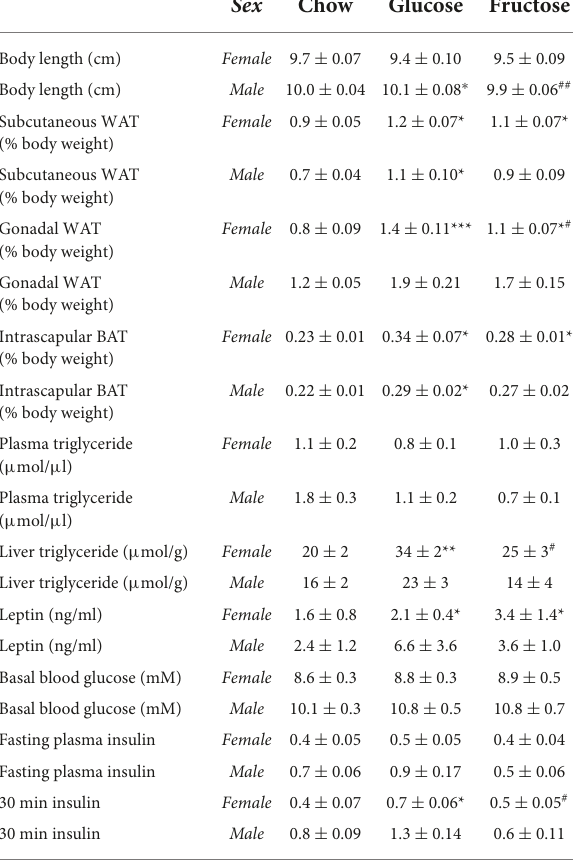
TABLE 5 Pup adiposity, triglyceride levels, and glucose homeostasis at 12 weeks of age in Part 2 (glucose vs. fructose). Sex Chow Glucose